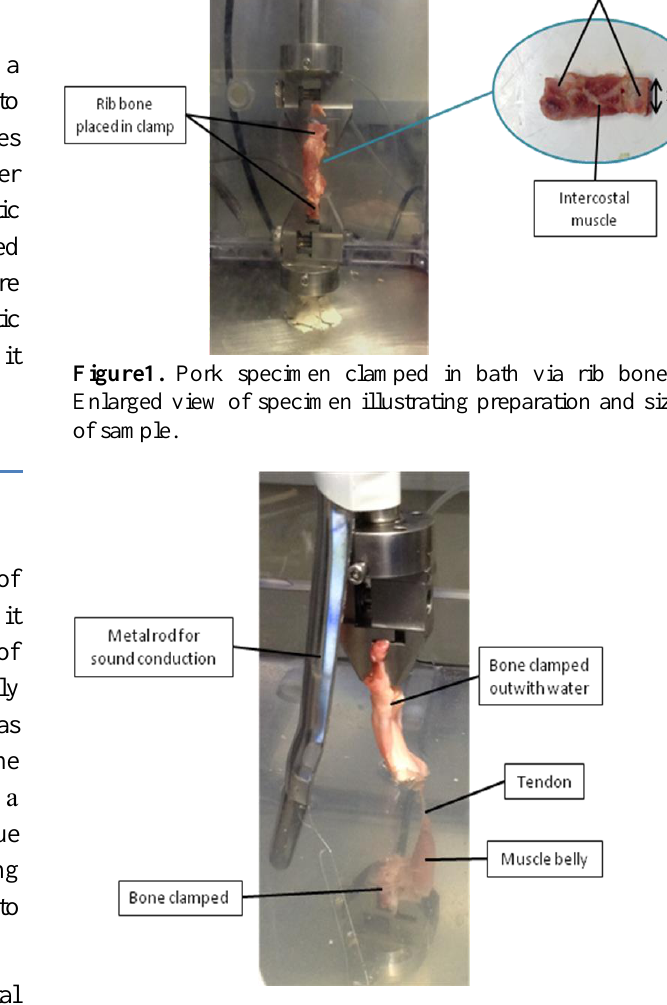
Figure 2. View looking downwards into bath with chicken specimen clamped in place (Test 1). As part of specimen was clamped out with the bath, a rod was used to conduct the “tapping” signal to synchronise data